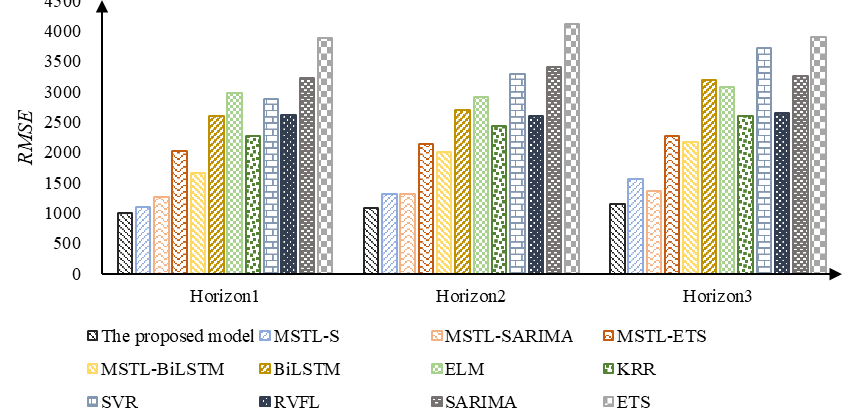
Figure 7. RMSE of each model in multi-step-ahead forecasting.